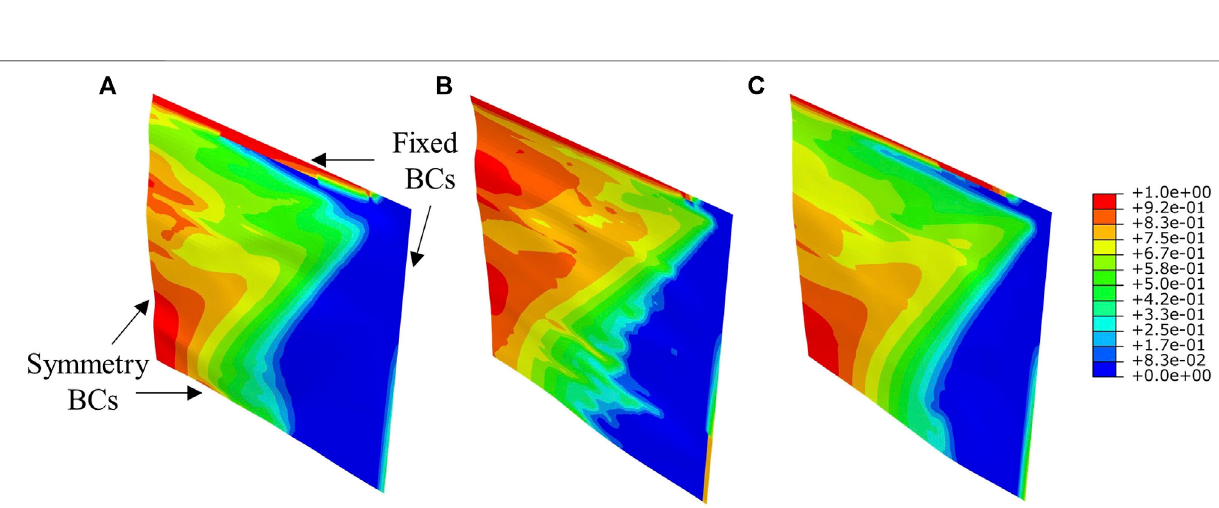
FIGURE8| DynamicresponsesofFMLplatesundertheimpulsiveloadof Z (cid:2) 1 . 46 m / kg 1 / 3 . (A) Thede fl ectiontimehistoriesattheplatecenter. (B) Comparisonof maximum positive de fl ection and fi nal de fl ection between aluminum and FML plates.